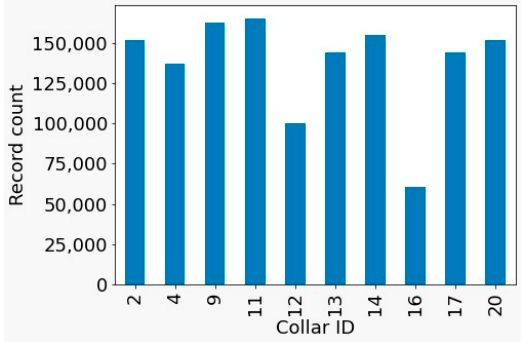
Figure 1. Record count for each sample collar.